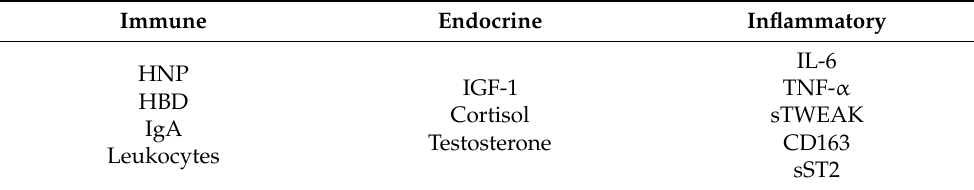
Table 1. The classification of the biomarkers addressed in this